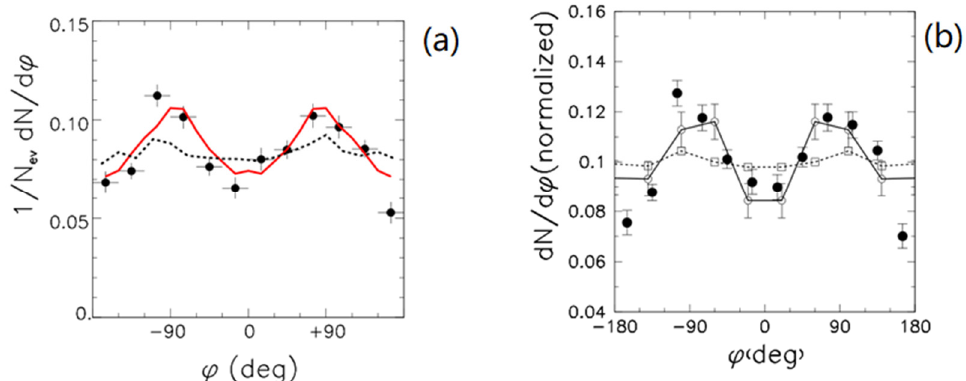
Figure 10. Azimuthal distribution of K + mesons measured in semi-central Au+Au collisions at 1A GeV (full dots). The kaons are analyzed for transverse momenta within a range of 0.2 GeV/c ≤ p t ≤ 0.8 GeV/c and for the normalized rapidity ranges of 0.4 ≤ y/y proj ≤ 0.6 ( a ) and 0.2 ≤ y/y proj ≤ 0.8 ( b ) [7]. The lines show the results of transport calculations using a RBUU model (left; [42]) and a QMD model (right; [43]), which both take into account rescattering; QMD also calculates Coulomb effects. Solid and dashed lines: calculations with and without in-medium K + N potential, respectively. Taken from [40].